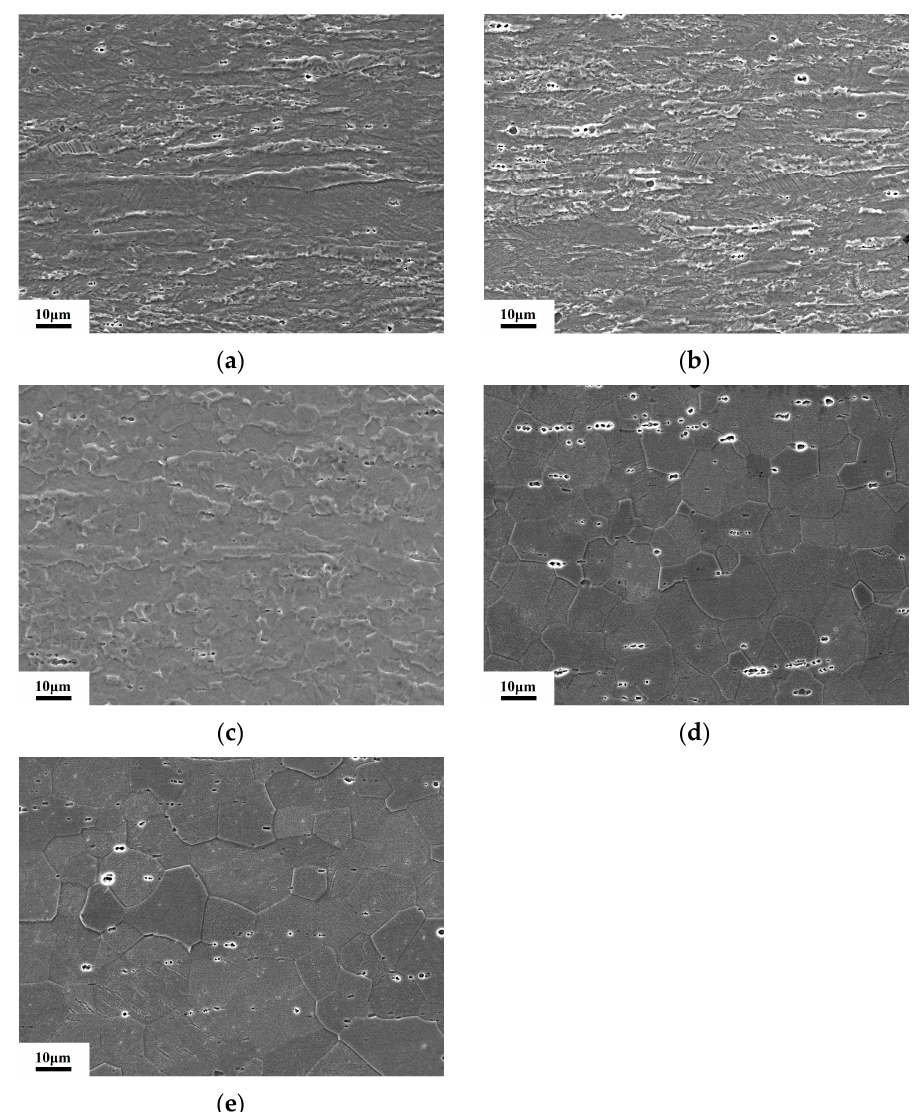
Figure 2. SEM micrographs of Ti 50 Ni 47 Fe 3 alloy after annealing at di ff erent temperatures. ( a ) 400 °C/60 min/AC; ( b ) 500 °C/60 min/AC; ( c ) 600 °C/60 min/AC; ( d ) 700 °C/60 min/AC; and ( e ) 800 °C/60 min/AC.